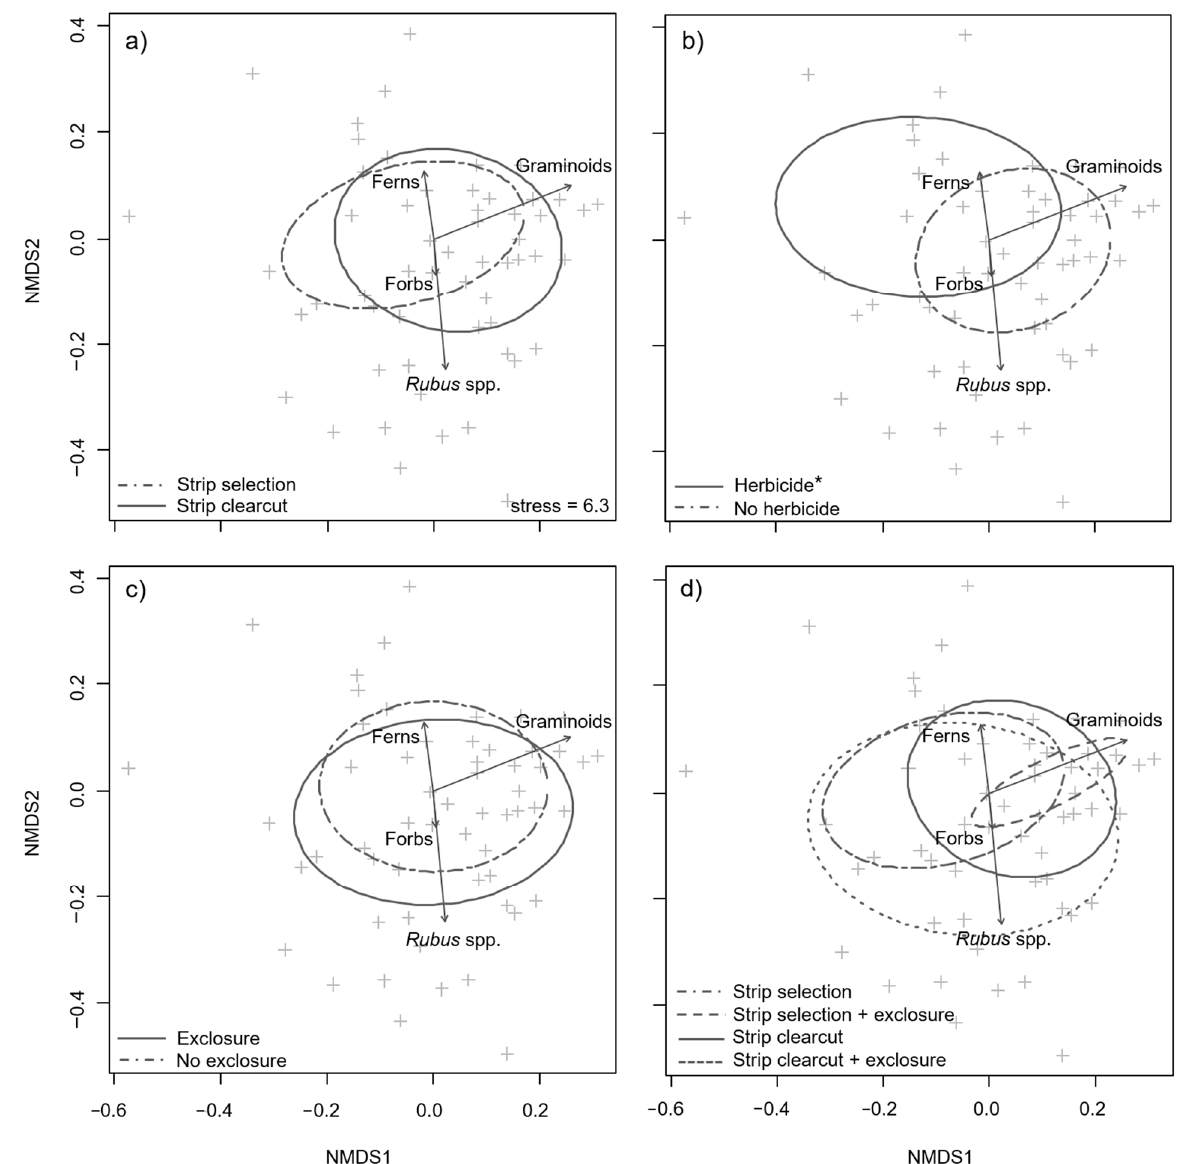
Figure 5. Nonmetric multidimensional scaling ordinations illustrating the relationships among treatments and changes in average cover (2017 cover minus 2015 cover) of ferns, forbs, graminoids, and Rubus spp. in 1 m 2 plots ( n = 107 plots), depicting two axes of a three-axis ordination. Ellipses indicate ( a ) harvest, ( b ) herbicide, ( c ) exclosure, and ( d ) harvest × exclosure treatments, based on the standard deviation of point scores for each plot. Points represent individual plots, and distances between points represent the similarity among plots (i.e., points closer together are more similar in composition). Cover among three 1 m 2 subplots was averaged prior to analysis. The direction and length of each vector indicate the relative treatment influence on the response variables. One ordination model was constructed, and ellipses highlighted separately for each treatment. * Asterisk indicates a significant difference between herbicide and no herbicide plots ( p < 0.05).